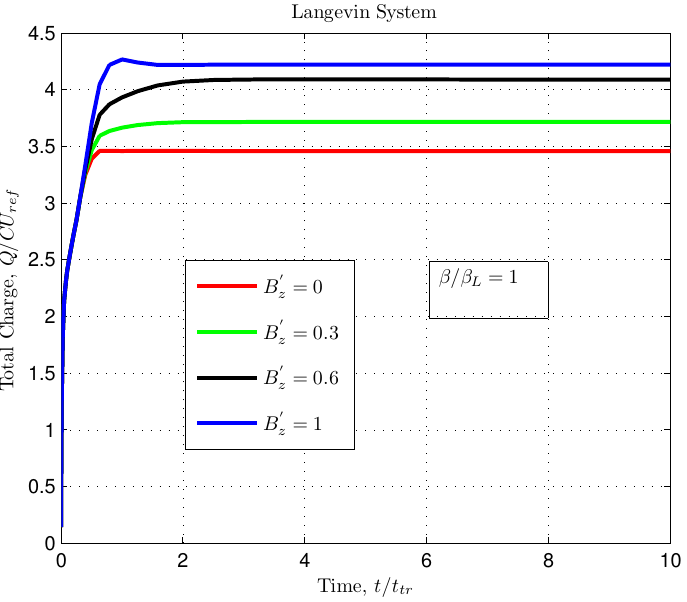
Figure 4. Total charge as a function of normalised time with varying magnetic fields for = Langevin system with β β L